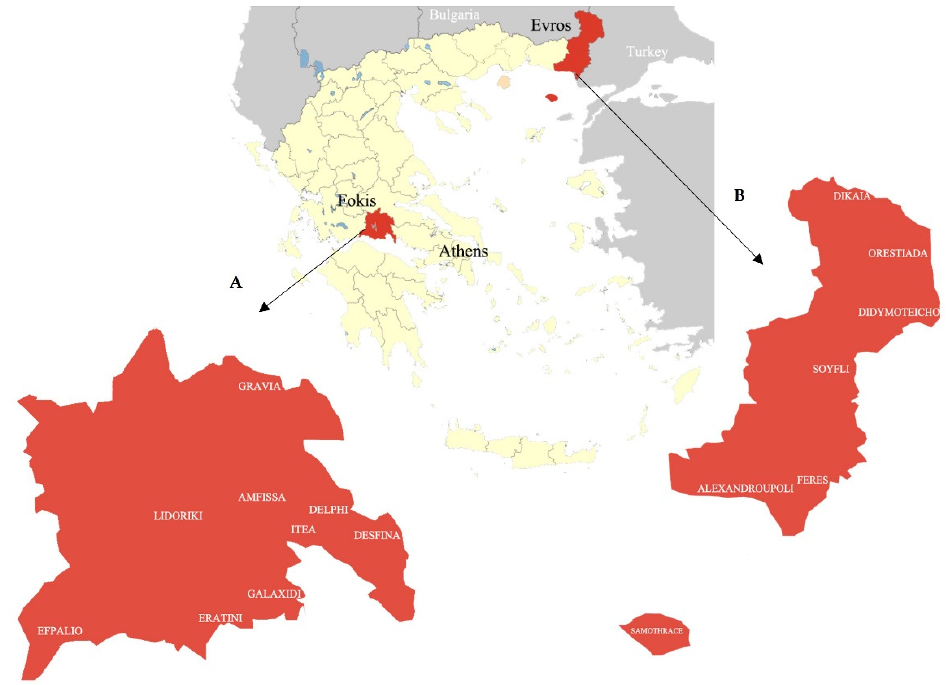
Figure 1. First two MMHUs of Greece: ( A ). MMHU of Fokis; ( B ). MMHU of Evros.